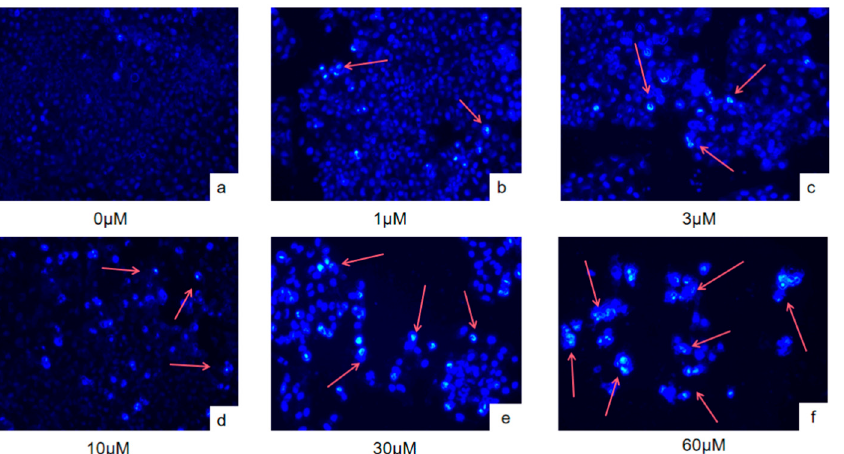
Figure 2. Effect of PYR26 on the morphology of cell nuclei ( × 400). ( a ) control, ( b ) 1 µ M, ( c ) 3 µ M, Figure 2. E ff ect of PYR26 on the morphology of cell nuclei (×400). ( a ) control, ( b ) 1 µ Μ , ( c ) 3 µ Μ , ( d ) 10 µ M, ( e ) 30 µ M and ( f ) 60 µ M. Red arrows pointed to the bright blue fluorescence emitted by ( d ) 10 µ Μ , ( e ) 30 µ Μ and ( f ) 60 µ Μ . Red arrows pointed to the bright blue fl uorescence emi tt ed by the apoptotic cells. the apoptotic cells.